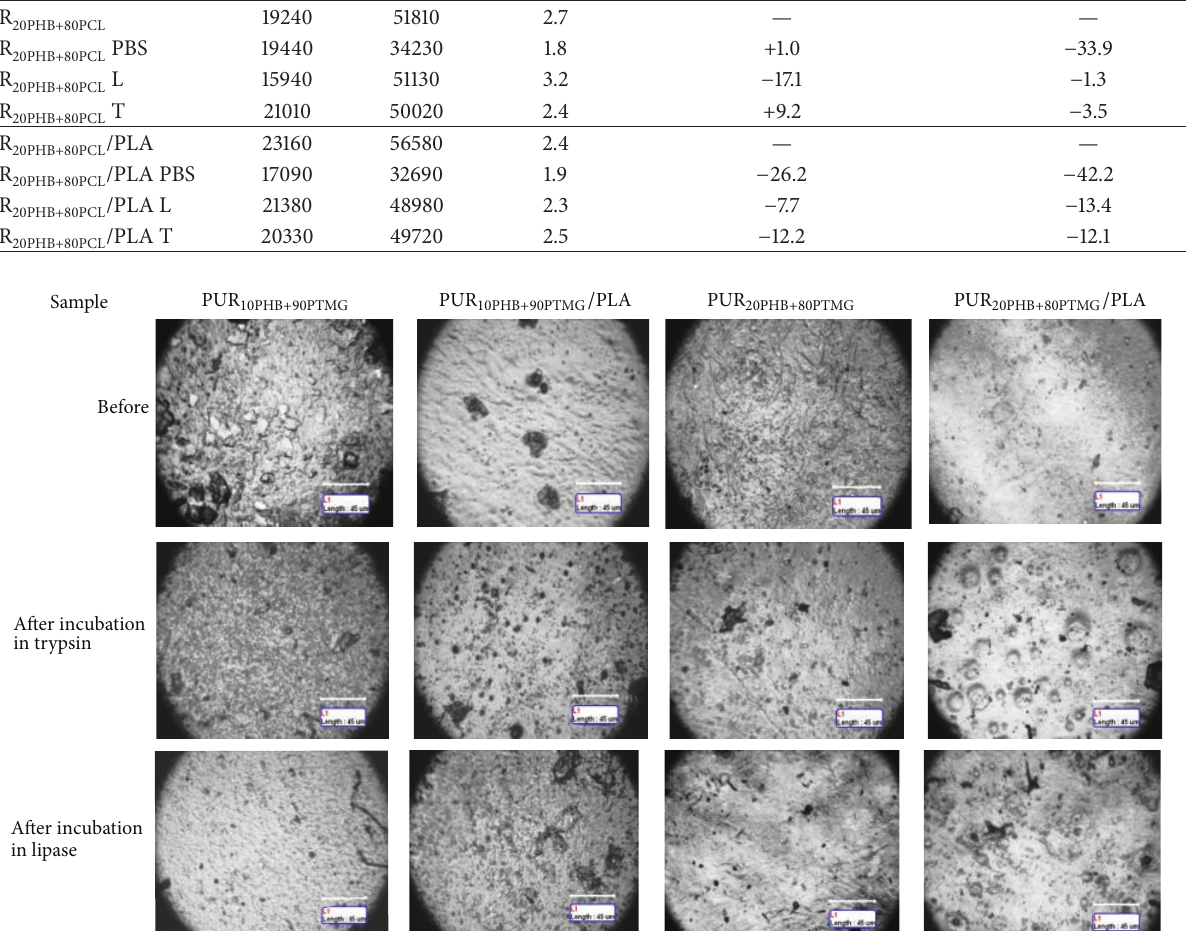
Figure 5: The surface structure of polyether-esterurethanes and their blends before and after incubation in enzyme solutions.